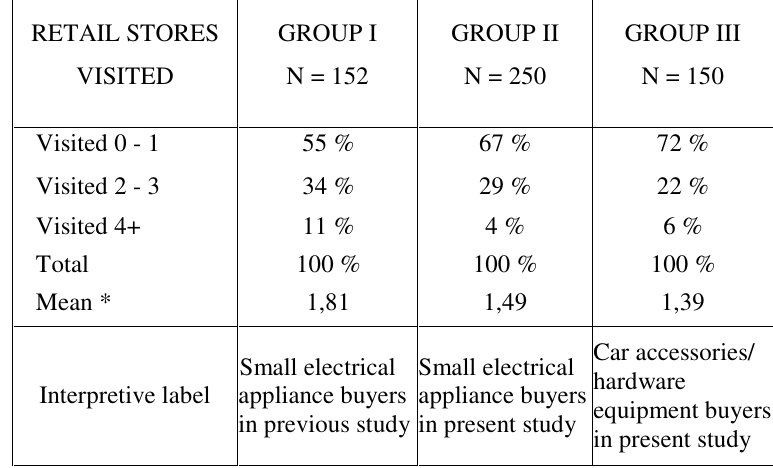
PATTERNS OF RETAIL SOURCE USAGE EXPRESSED AS PERCENTAGE RESPONSES BY SAMPLE